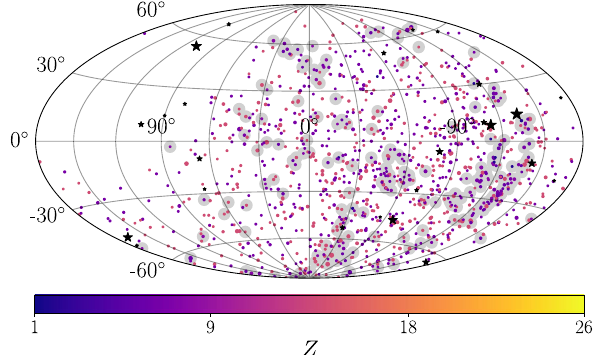
Fig. 6 Example of benchmark 2 scenario consisting of an astrophys- ical simulation including deflection in the JF12 model for the GMF. Cosmic rays originate from uniformly distributed sources of density ρ = 10 − 2 Mpc − 3 and are attenuated by extragalactic photon fields. S Gray shaded events denote cosmic rays which originate from a source with at least three contributing events. For this specific source distribu- tion the strongest source contributes 30 cosmic rays, which corresponds to the median value of 1000 simulated universes for this source density. Thestarsymbolsdenotesourcedirectionswherethesizeisproportional to the cosmic-ray contribution. The skymap is shown in the Galactic coordinate